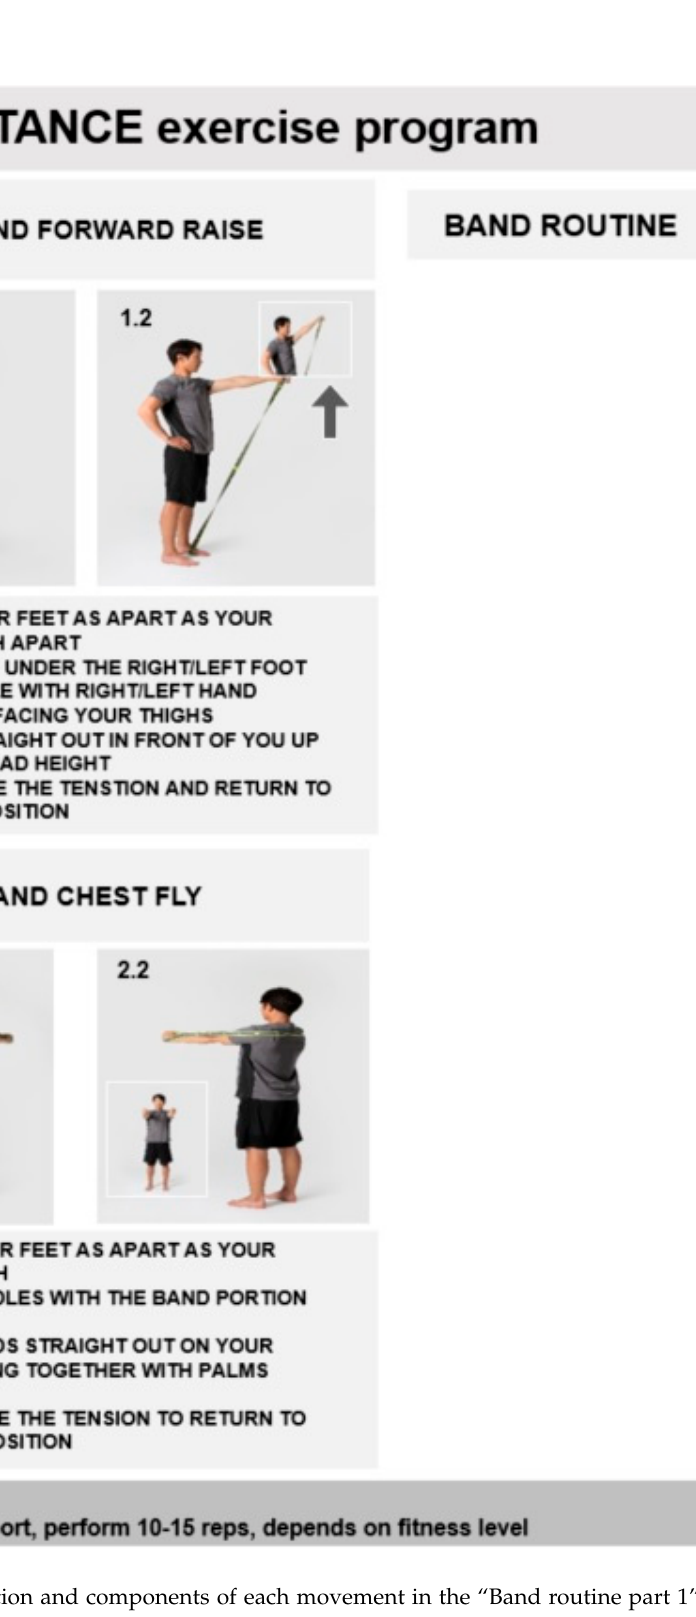
Figure A13. Detailed description and components of each movement in the “Band routine part 1” resistance exercise.